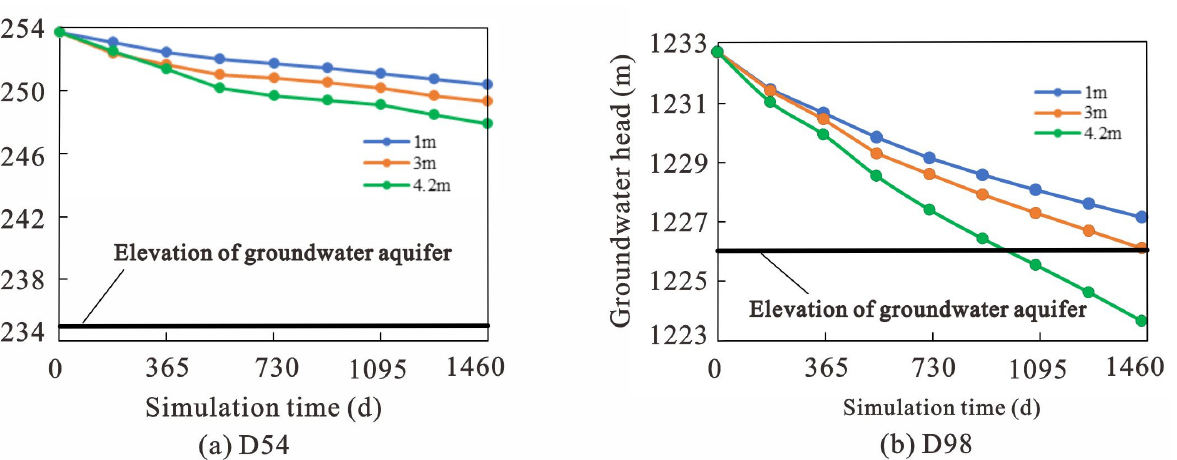
Figure 9. Variation in groundwater level in the upper aquifer system under different thicknesses of the coal seam: ( a ) D54, ( b ) D98.